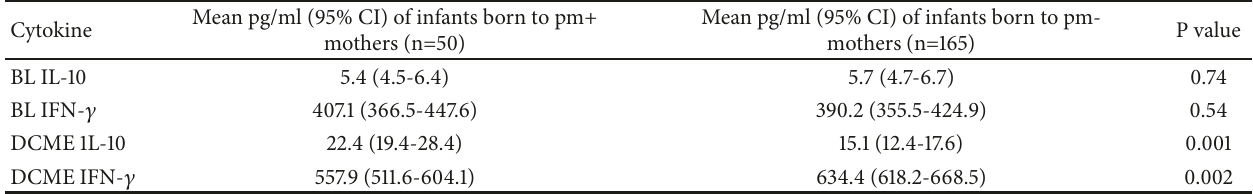
Mean pg/ml (95% CI) of infants born to pm- mothers (n=165)